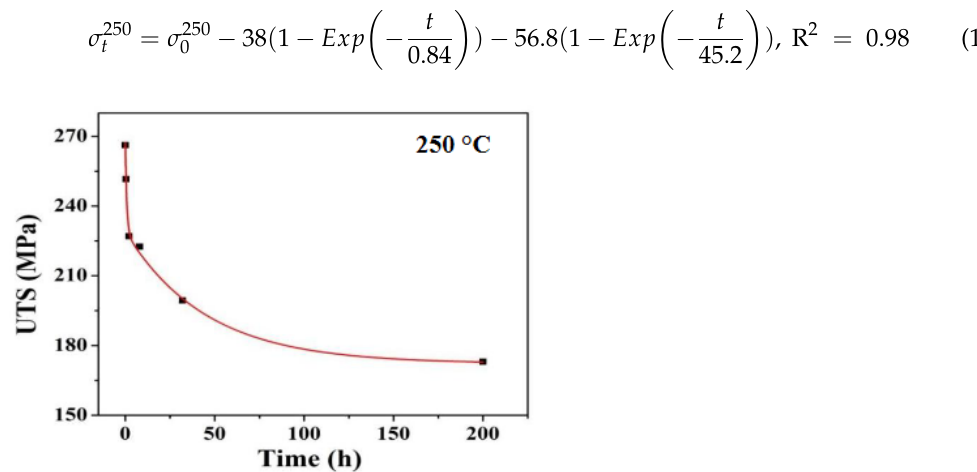
Figure 8. The ultimate tensile strength of the Al-Si-Cu-Ni-Mg alloy at room temperature fitted with exposure time at 250 °C for different times. exposure time at 250 ◦ C for different times.